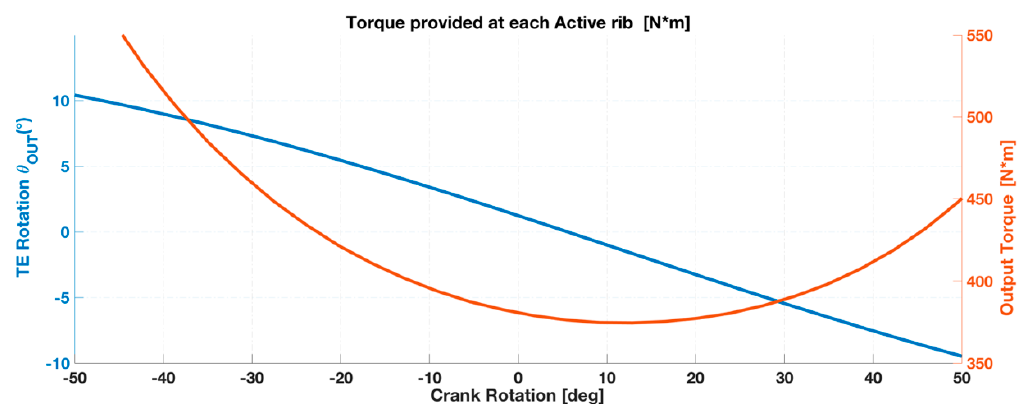
Figure 20. Actuating torque provided by each actuation systems to its active rib during operations.